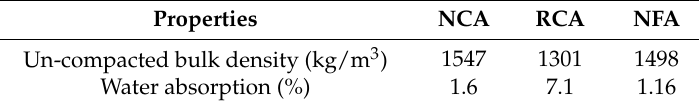
Table 3. Properties of natural coarse aggregate (NCA) and recycled coarse aggregate (RCA).